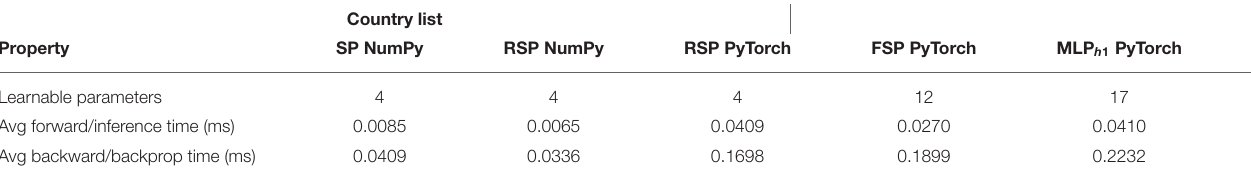
TABLE 4 | Spatial complexity and learning times of different architectures.